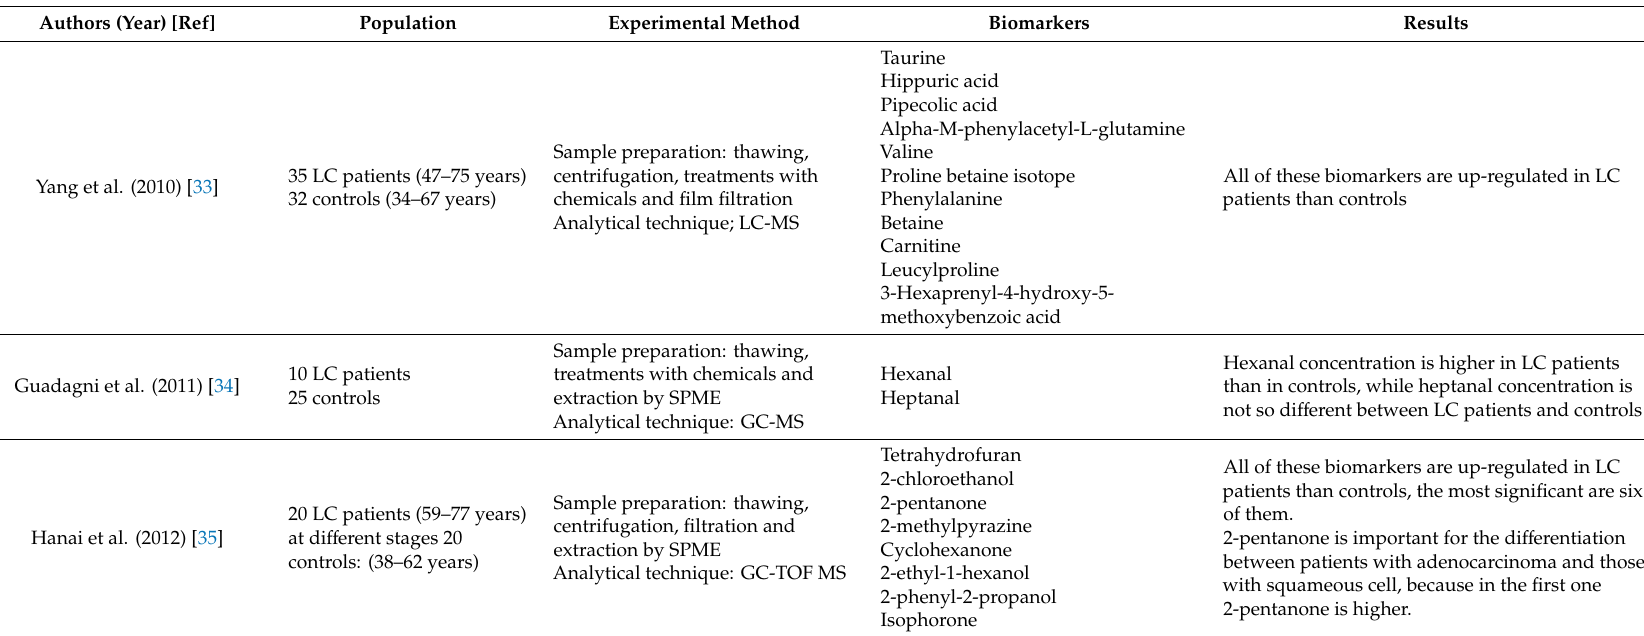
Table 1. Literary studies investigating urinary biomarkers for lung cancer. GC-MS: gas chromatography linked to mass spectrometry; SPME: solid-phase microextraction fiber; LC: lung